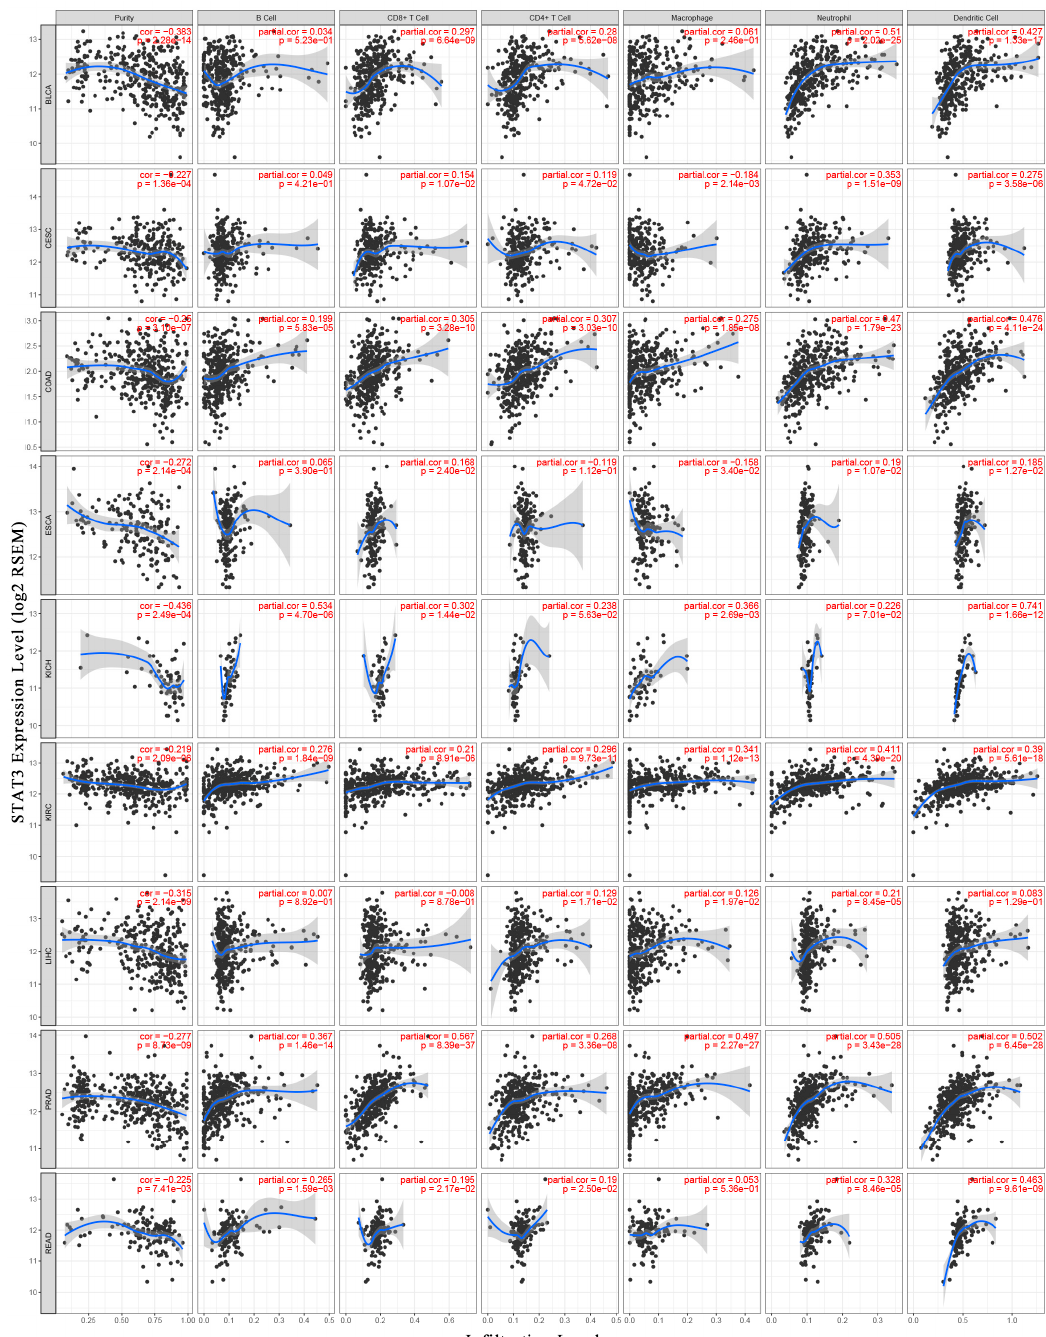
Figure 3. Correlation analysis between STAT3 and immune infiltration level. The correlations between STAT3 and tumor purity, STAT3 and infiltration levels of six TIICs (B-cells, CD4 + T-cells, CD8 + T-cells, macrophages, neutrophils, and dendritic cells) were analyzed respectively by TIMER in BLCA, cervical squamous cell carcinoma and endocervical adenocarcinoma (CESC), COAD, esophageal carcinoma (ESCA), KICH, KIRC, liver hepatocellular carcinoma (LIHC), prostate adenocarcinoma (PRAD), and rectum adenocarcinoma (READ).